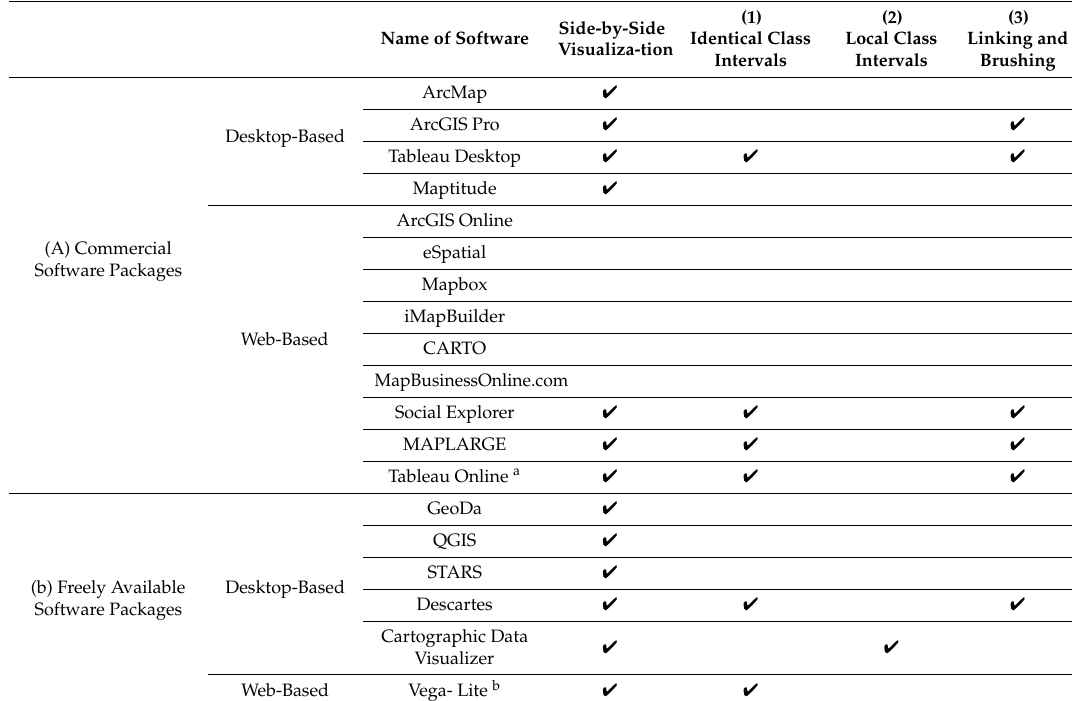
Table 1. Software Packages containing a choropleth mapping tool and three components that each software provides. Component (1) is an automated method to create multiple choropleth maps with identical class intervals. Component (2) is a function that allows users to promptly recreate class intervals at any zoomed-in area. Component (3) is linking and brushing for synchronous exploration of multiple choropleth maps. a Tableau is an information visualization environment that includes a utility to draw multiple choropleth maps. b Vega-Lite is an open-source graphing library containing a choropleth mapping